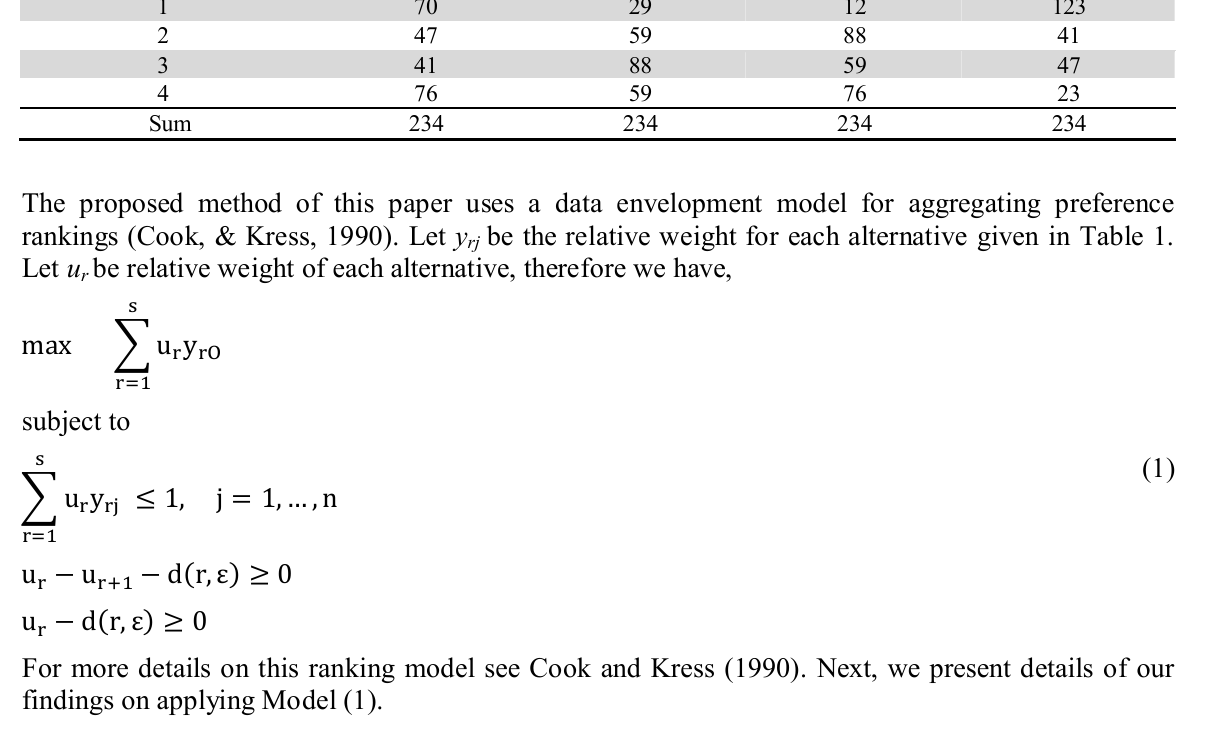
Cultural Social